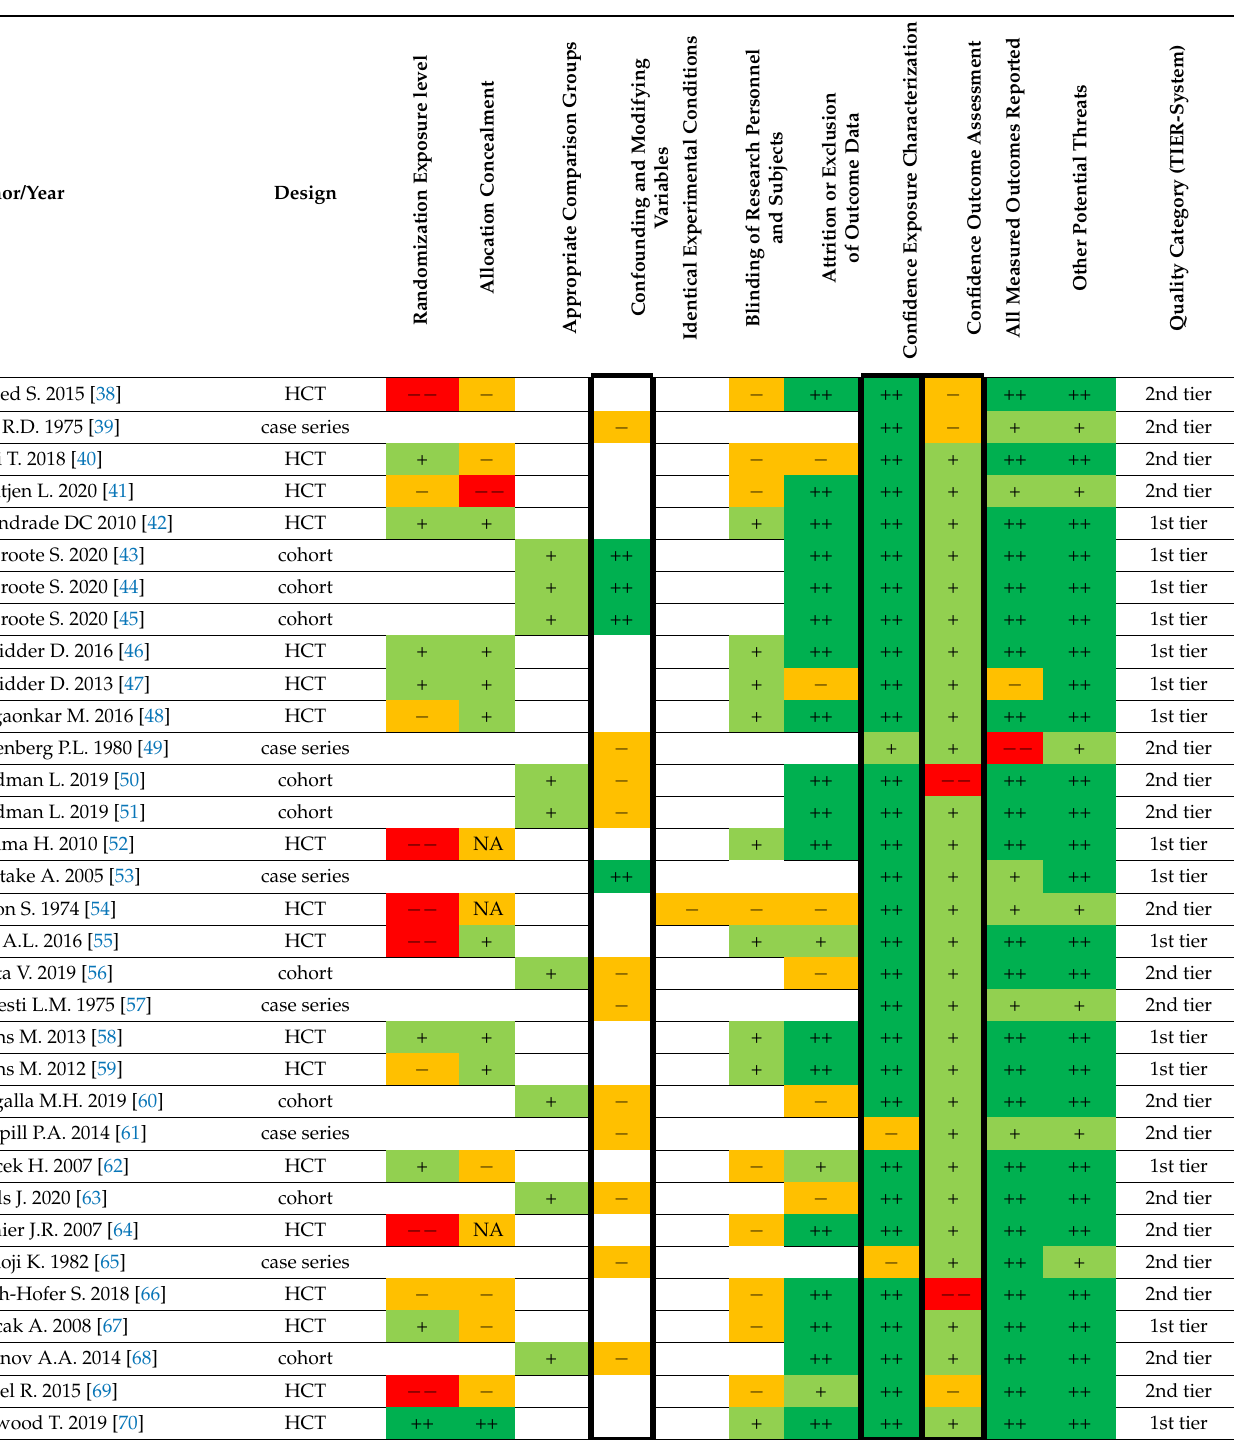
Table 3. Risk of bias in individual human